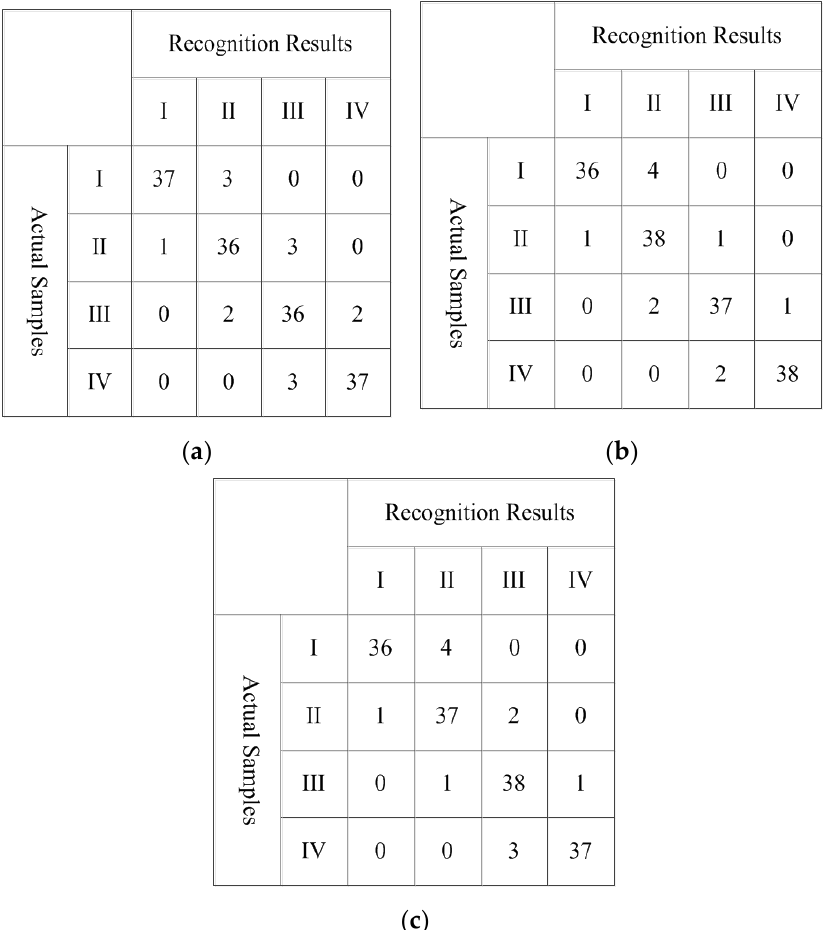
Figure 10. Confusion matrix of the recognition results: ( a ) in 80% relative humidity, ( b ) in 85% relative humidity, and ( c ) in 90% relative humidity. Table 3. Recognition results of SAE–DBN.